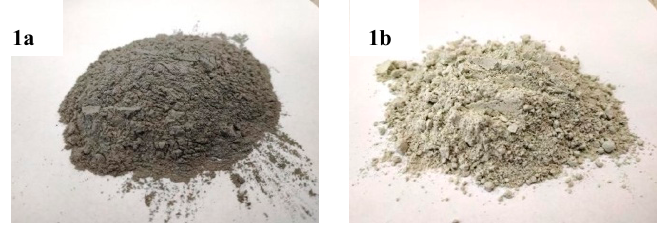
Figure 1. Zeolite materials used in the research: Na-P1 ( a ), clinoptilolite ( b ).